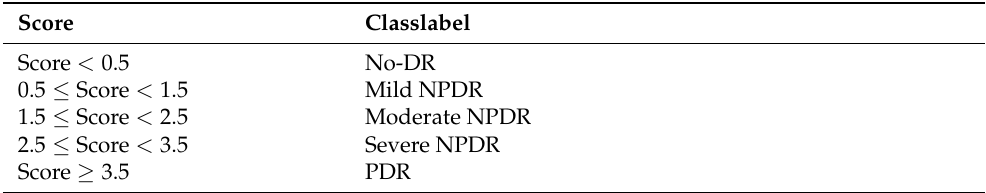
Table 3. Classification